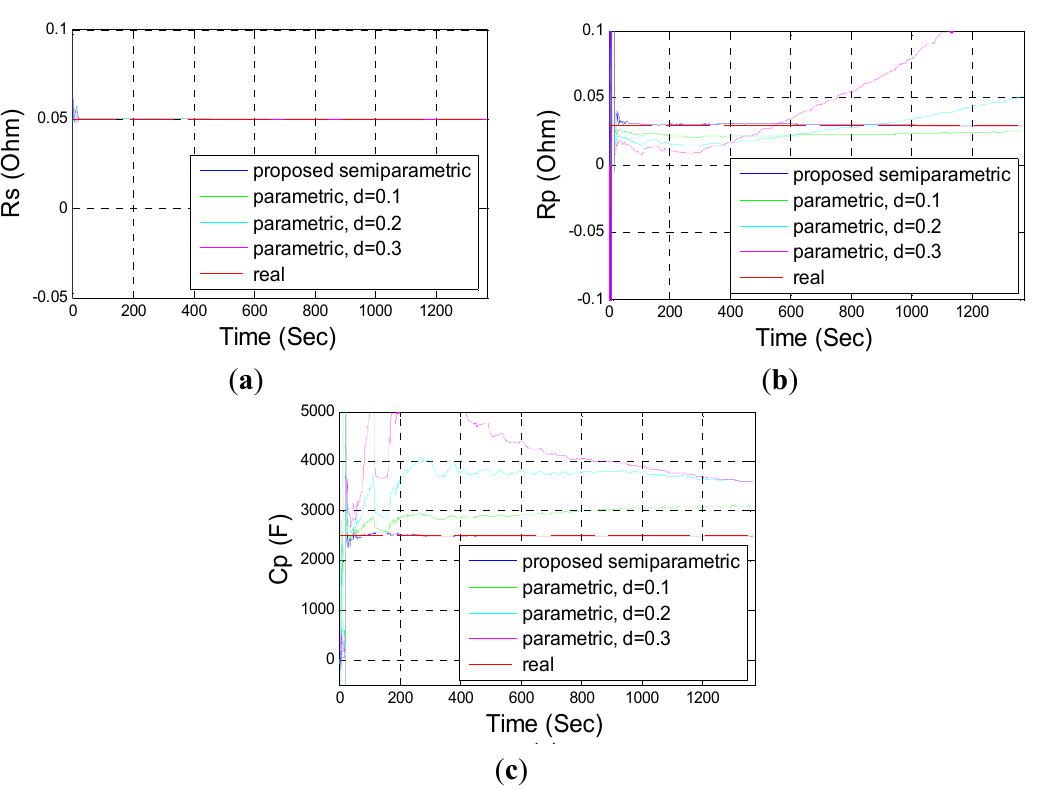
Figure 4. Estimated results of equivalent circuit parameters with the semiparametric